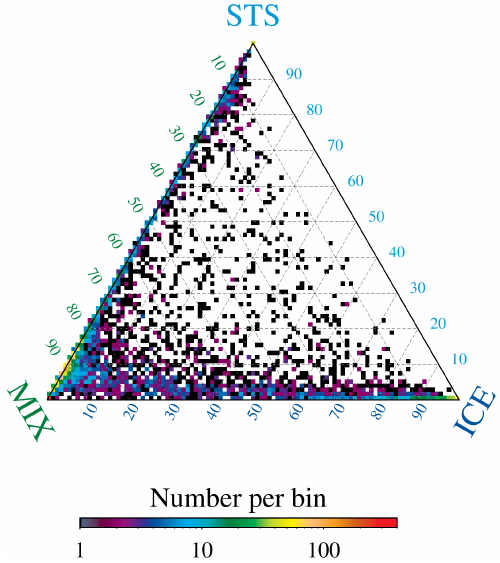
Figure 8. Ternary density plot of the relative proportions of STS/MIX/ICE occurring in the MLS geometric FOV at temper- atures below the ice frost point for the 2013 Antarctic winter at